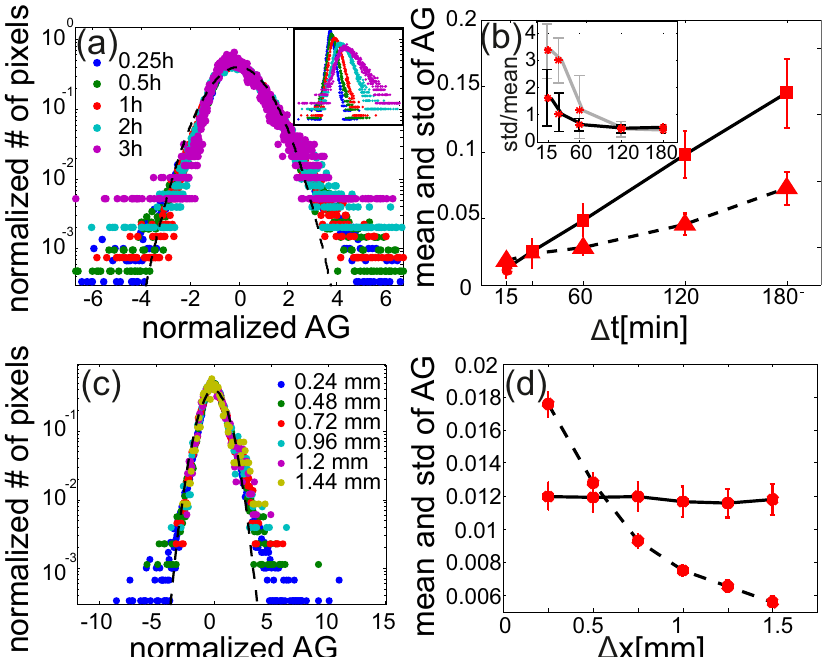
Fig. 2 Coarse graining in time and space of area-growth fi elds. a Histograms of all area-growth ( AG ) values taken during 48 h (more than 70k data points), with space resolution Δ x ¼ 250 μ m and different time intervals Δ t (indicated in the fi gure). All histograms are normalized to integrate to 1 (i.e., are treated as probability density functions), shifted to have zero mean, and normalized to have the same std. The dashed line is a Gaussian distribution with the same mean and std. Inset: the same histograms before equalizing the mean and std. b The mean (solid line) and std (dashed line) of the histograms in a, as functions of Δ t . Error bars are the standard deviation of the measurements. Inset: the ratio std for measurements that were taken during day time mean (solid line, 64k data points) and during night time (dashed line, 26k data points). c Histograms of all AG values taken during 48 h with Δ t ¼ 15min and different Δ x (indicated in the fi gure). The histograms are normalized to have the same area and zero mean. The dashed line is a Gaussian distribution with the same mean and std. d The mean (solid line) and std (dashed line) of the histograms in c , as functions of Δ x . Error bars are the standard deviation of the measurements, sometimes smaller than the symbol.